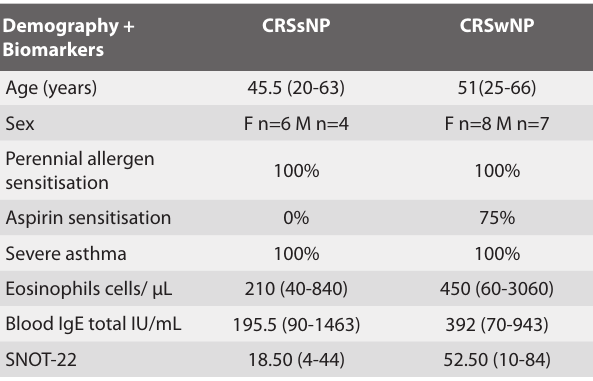
Table 1. Summary of patient characteristics and baseline biomarkers.